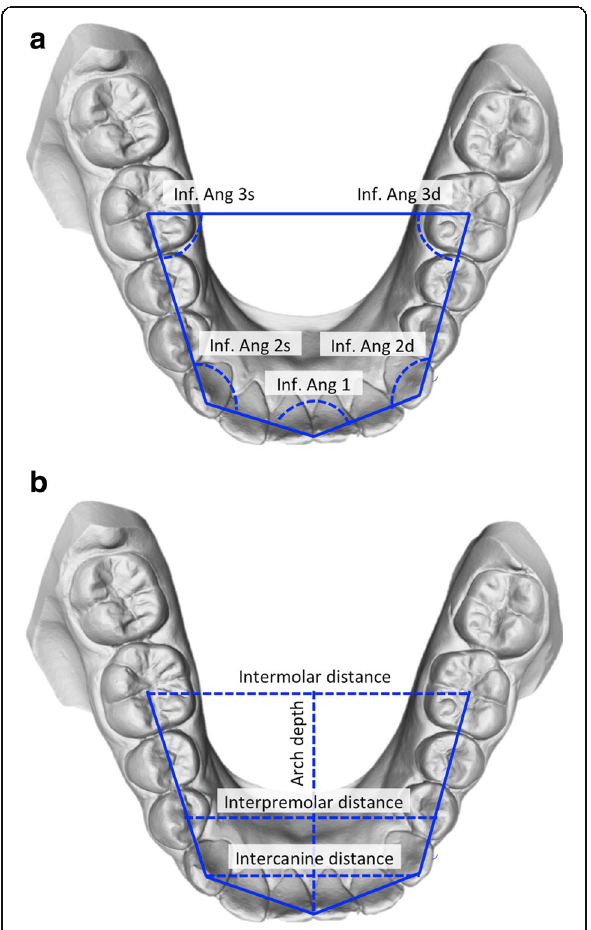
Fig. 3 a , b Method and variables for the shape analysis of the